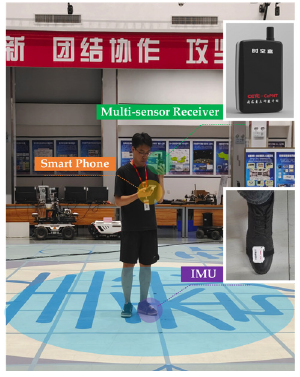
Figure 6. Schematic diagram of multi-dimensional data collection.